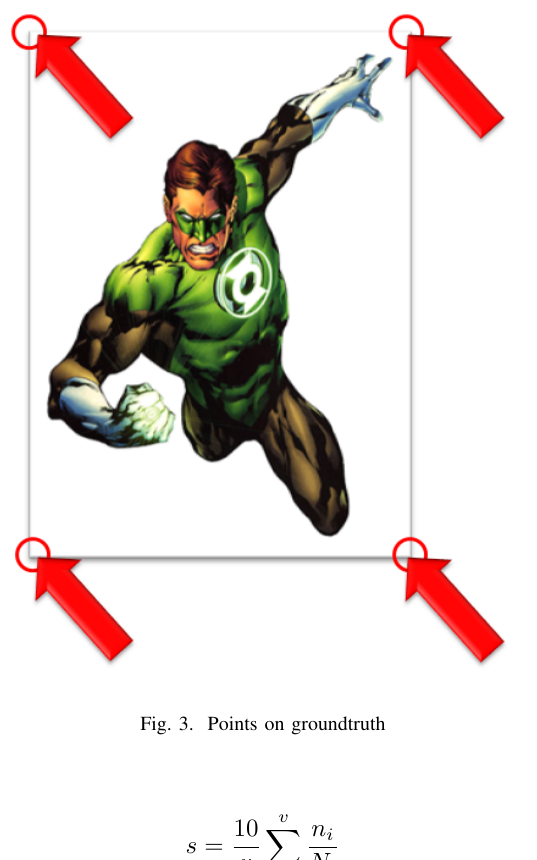
Fig. 3. Points on